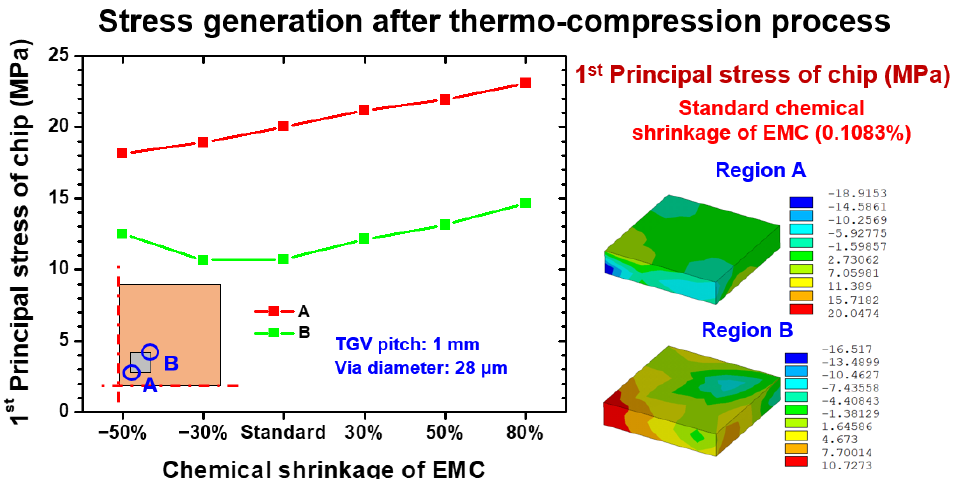
Figure 9. EMC shrinkage dependence first principal stress on the relevant location of the Si chip after the thermocompression process.